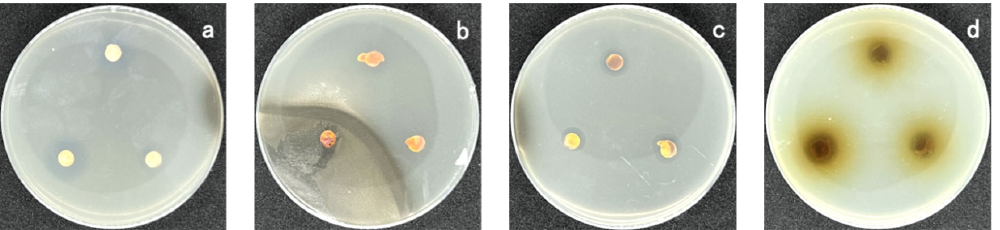
Figure 2. Inhibitory effects of steam distillation extract ( a ), n-hexane extract ( b ), petroleum ether Figure 2. Inhibitory e ff ects of steam distillation extract ( a ), n-hexane extract ( b ), petroleum ether Figure 2. Inhibitory e ff ects of steam distillation extract ( a ), n-hexane extract ( b ), petroleum ether Figure 2. Inhibitory e ff ects of steam distillation extract ( a ), n-hexane extract ( b ), petroleum ether extract ( c ), and ethanol extract ( d ) on Staphylococcus aureus . extract ( c ), and ethanol extract ( d ) on Staphylococcus aureus . extract ( c ), and ethanol extract ( d ) on Staphylococcus aureus . extract ( c ), and ethanol extract ( d ) on Staphylococcus aureus .